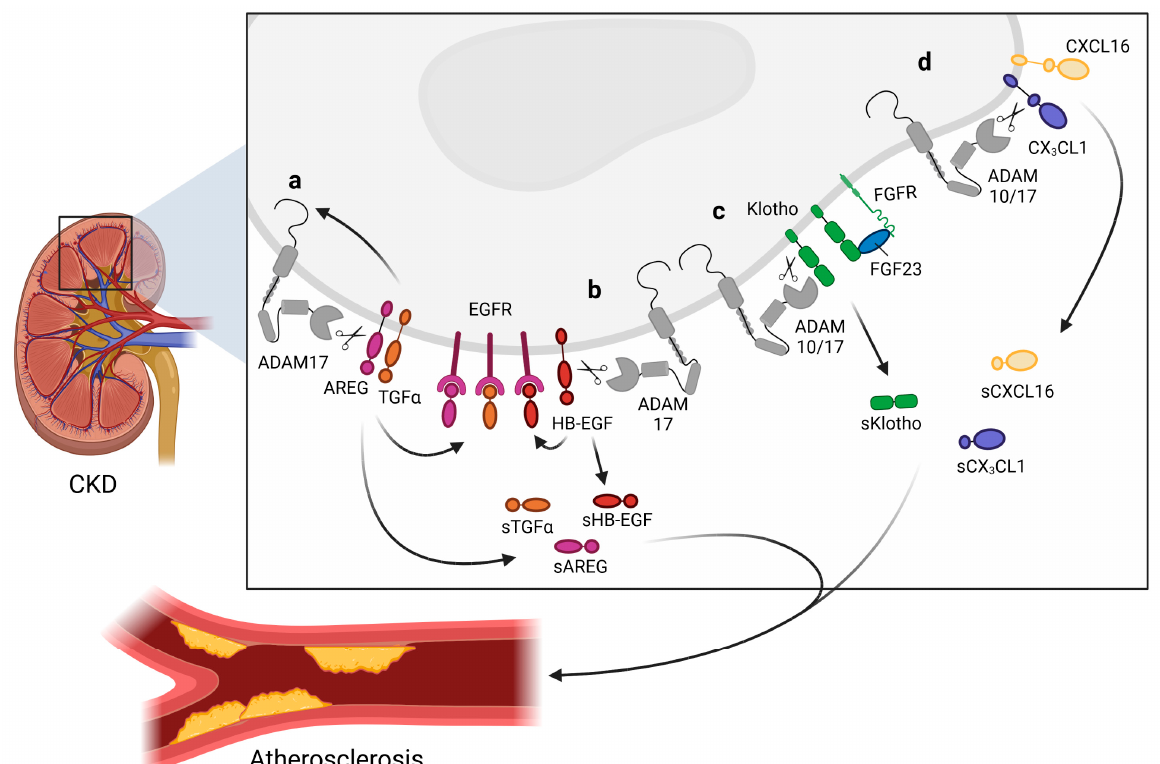
Figure 2. Overview of shedding activities of a disintegrin and metalloproteinases (ADAM ) 10 and ADAM17 in the kidney. The shedding of ADAM10 and ADAM17 substrates in chronic kidney disease (CKD). ( a ) Activation of the epidermal growth factor receptor (EGFR) pathway by shedding amphiregulin (AREG) and transforming growth factor α (TGF α ) by ADAM17. AREG and TGF α shedding results in the upregulation of ADAM17 on the transmembrane. ( b ) Additionally, heparin- binding EGF-like growth factor (HB-EGF) is cleaved by ADAM10, also activating the EGFR pathway. ( c ) Shedding of Klotho is mediated by ADAM10 as well as ADAM17, resulting in soluble Klotho (sKlotho), which exerts renoprotective effects. Membrane-bound Klotho, fibroblast growth factor receptor (FGFR), and fibroblast growth factors 23 (FGF23) are from a trimeric signaling complex regulating kidney homeostasis. ( d ) ADAM10 and ADAM17 can shed chemokine (C-X3-C motif) ligand 1 (CX 3 CL1) and chemokine (C-X-C motif) ligand 16 (CXCL16), producing soluble chemokines. sAREG, sTGF α , sHB-EGF, sKlotho, sCX 3 CL1, and sCXCL16 are all released into the circulation and can translocate to the arterial endothelium and affect atherosclerotic processes. Created with